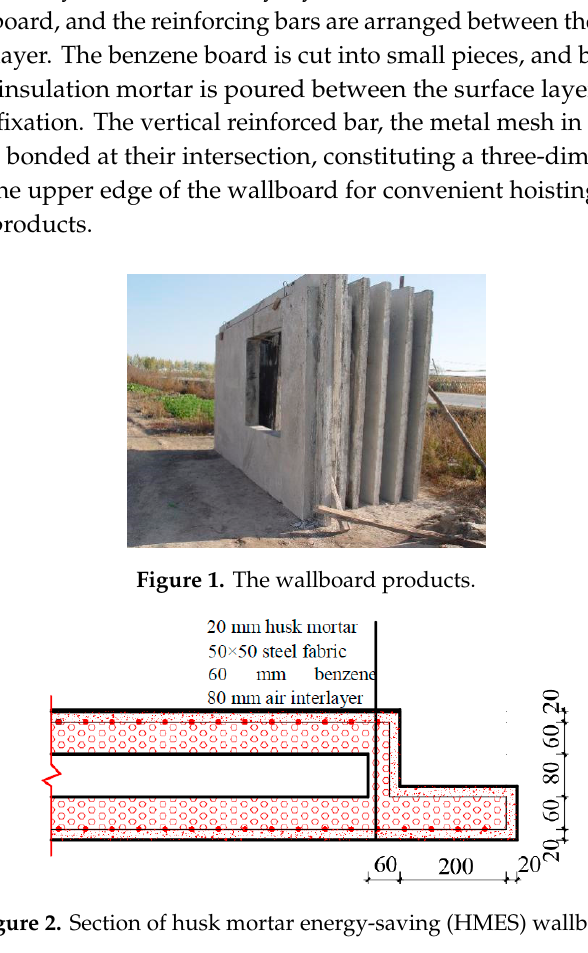
Figure 2. Section of husk mortar energy-saving (HMES) wallboard.